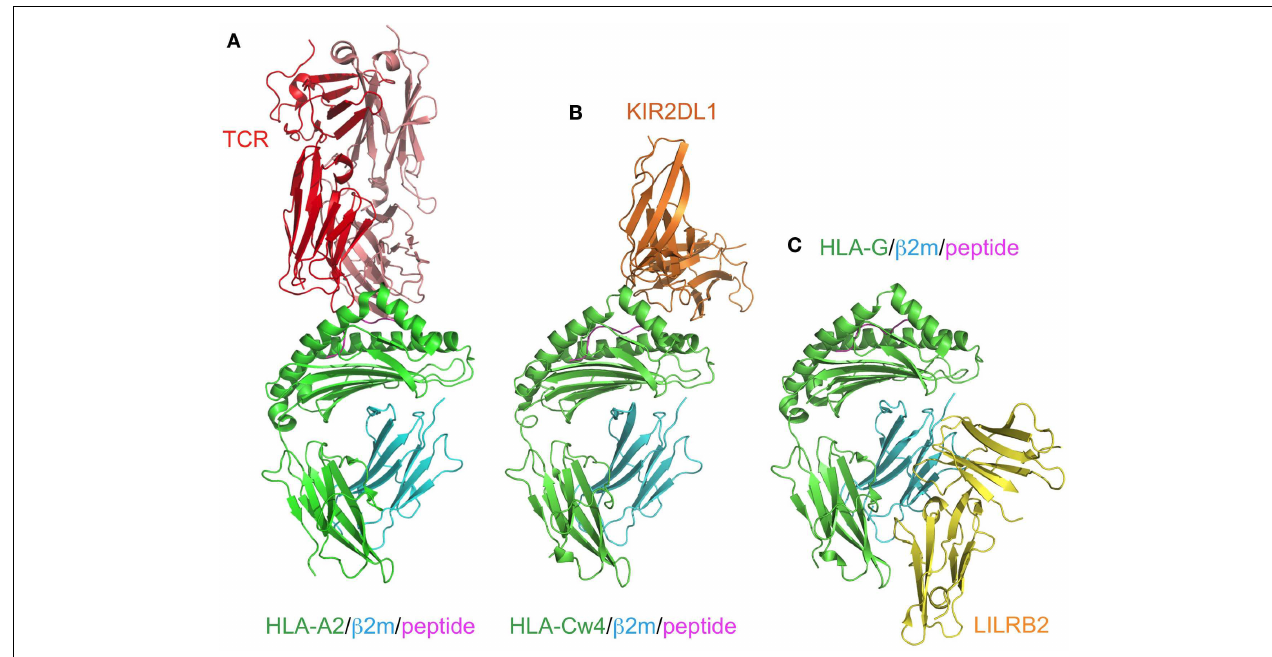
center of the peptide and the α 1– α 3 domain of HLA-A2. (B) KIR2DL1 binds to both the α 1 and α 2 helices of HLA and the C-terminal end of the peptide.This binding region contains the 77N/S and 80K/N residues, which determine the ligand specificity. (C) LILRB2 binds to the α 3 domain and β 2m, which are conserved regions among the